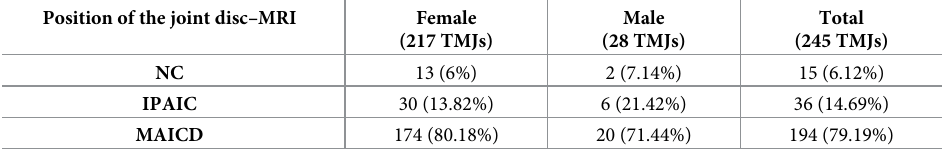
Table 3. Distribution of the position of the TMJ disc according to the second MRI. Position of the joint disc–MRI Female Male Total (217 TMJs) (28 TMJs) (245 TMJs) NC 13 (6%) 2 (7.14%) 15 (6.12%) IPAIC 30 (13.82%) 6 (21.42%) 36 (14.69%) MAICD 174 (80.18%) 20 (71.44%) 194